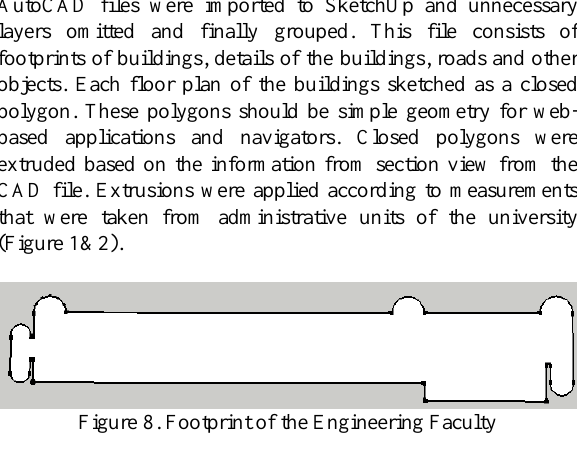
Figure 8. Footprint of the Engineering Faculty